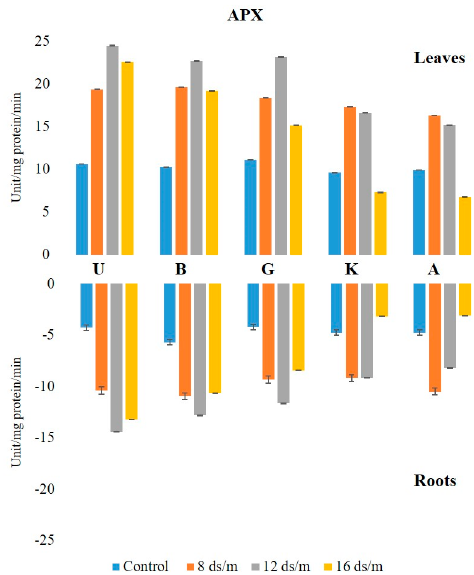
Figure 8. Effect of NaCl-mediated stress at 100 days of treatment on APX activity in leaves and roots of pistachio.